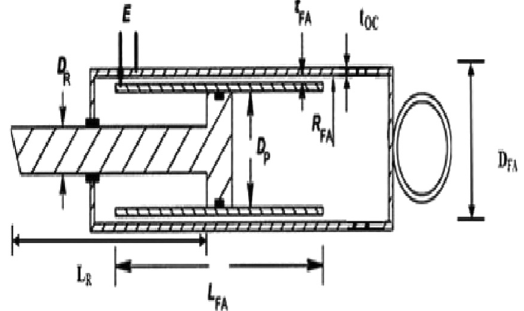
Figure 1: Cut section model of ER damper. E – applied voltage to